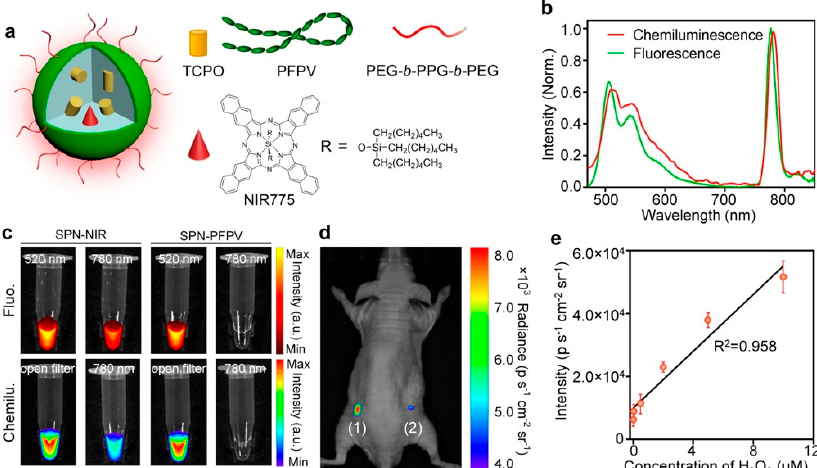
Figure 16. Semiconducting polymer nanoparticles emitting in the NIR (SPN-NIR) developed for CRET-based imaging of H 2 O 2 . ( a ) Schematic of the SPN-NIR. The polyfluorene-based semiconducting polymer PFPV, chemiluminescent substrate TCPO, and naphthalocyanine dye NIR775 were co-precipitated with the amphiphilic triblock copolymer PEG- b -PPG- b -PEG to create SPN-NIR particles with hydrodynamic diameters of 15–25 nm. ( b ) Chemiluminescence and fluorescence spectra of SPN-NIR. Chemiluminescence was induced by the addition of excessive H 2 O 2 (10 mM). ( c ) Representative chemiluminescence and fluorescence images of SPNs (18 µg/mL, 0.1 mL) in the presence of H 2 O 2 (10 mM). The fluorescence signals were detected at 520 or 780 nm; the chemiluminescence signals were detected with open filter or at 780 nm. ( d ) In vivo imaging of exogenous H 2 O 2 using SPN-NIR. Representative chemiluminescence image of mouse with the subcutaneous implantation of (1) H 2 O 2 (8 nM) + SPN-NIR (0.1 mg/mL, 0.1 mL) and (2) SPN-NIR (0.1 mg/mL, 0.1 mL). ( e ) In vivo chemiluminescence intensities of the subcutaneous inclusion of SPN-NIR as a function of